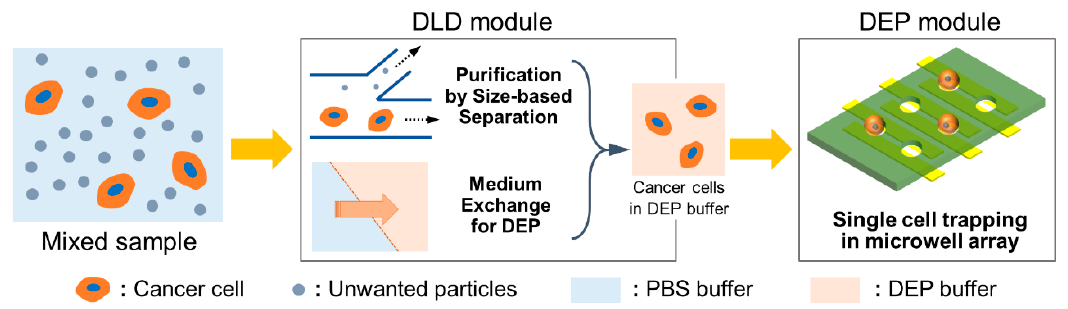
Figure 1. Schematic flow of processing samples via sequential cell-processing system.